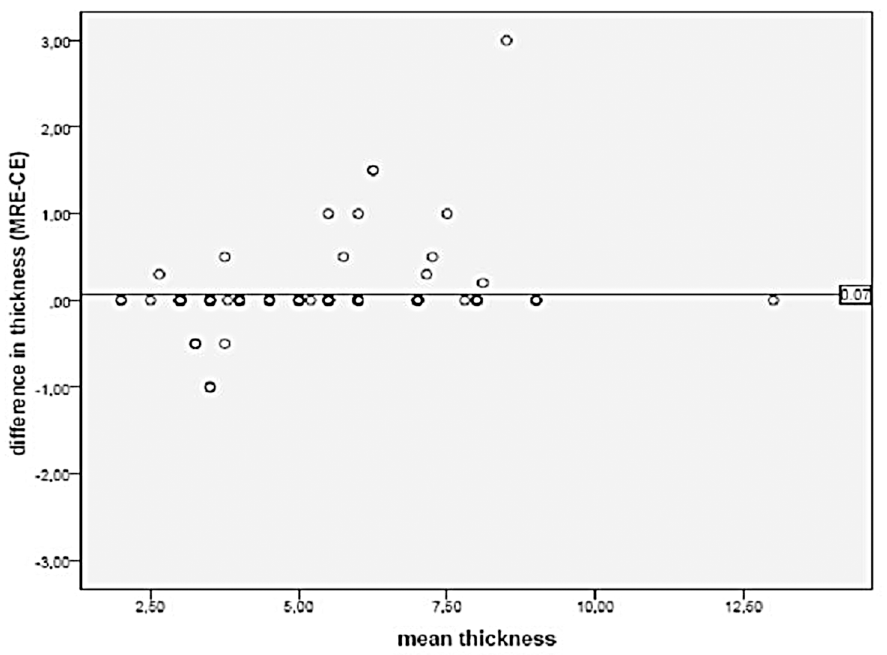
Fig 7. The relation between the mean wall thickness and the difference in wall thickness measured by MR Enterography and Contrast Enhanced Ultrasound.